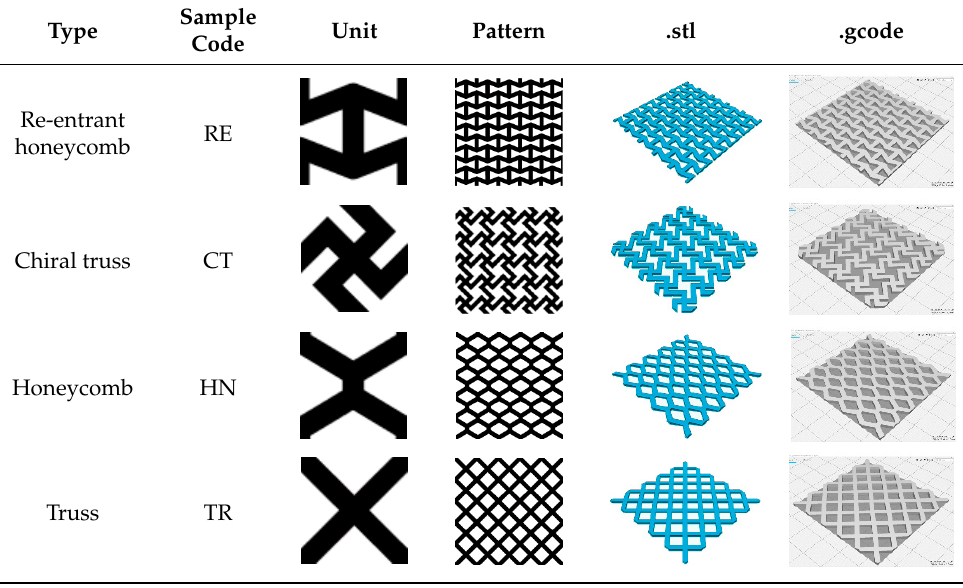
Table 1. Sample code and 3D modelling of various auxetic patterns.